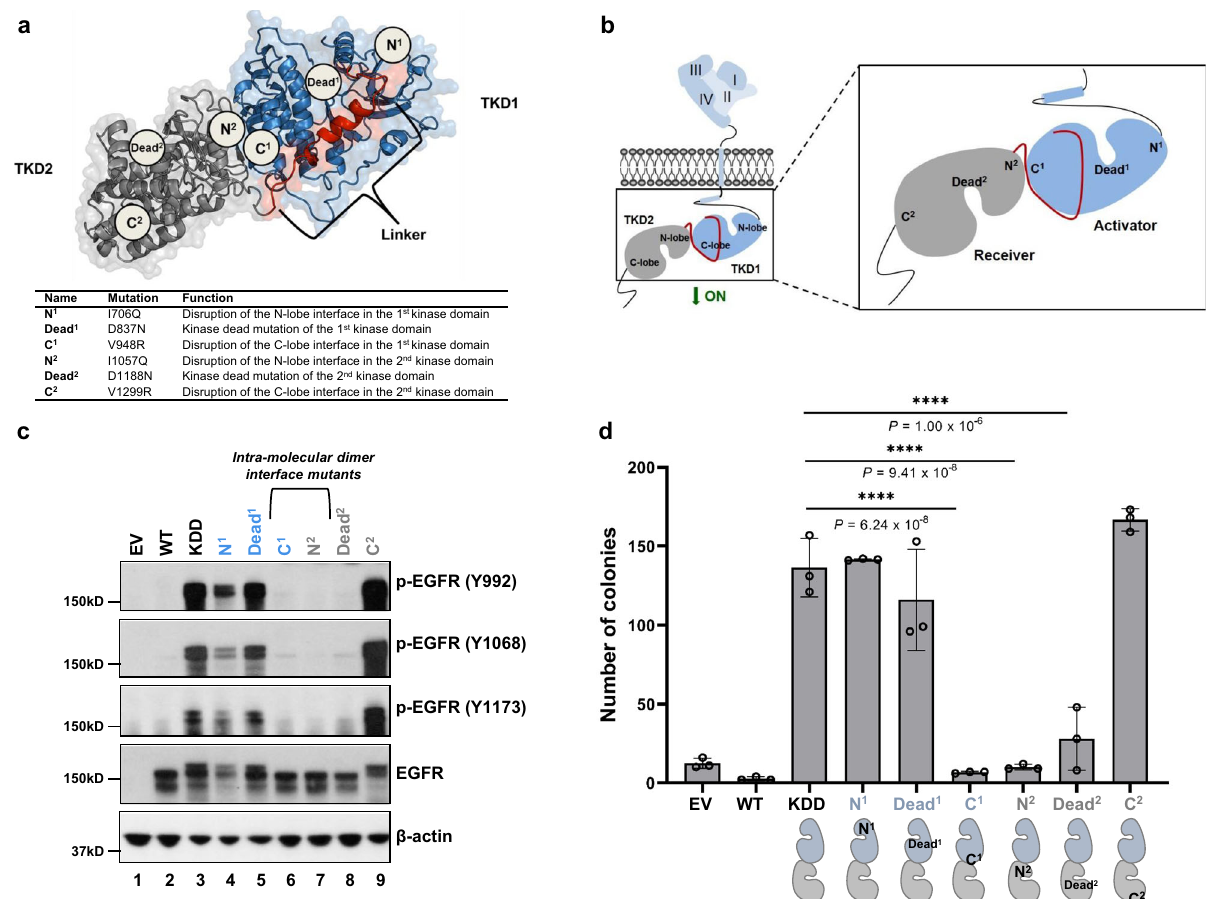
Fig. 1 Mutations disrupting the potential intra-molecular dimer interface abrogate phosphorylation of EGFR-KDD and anchorage-independent growth. a Ribbon diagram and space- fi lling model of EGFR-KDD kinase domains. Mutations constructed in this study were labeled. b Schematic representation of mutations we constructed in this study. We generated point mutations disrupting the potential intra- (C 1 , N 2 ) and inter-molecular (N 1 , C 2 ) dimer interface as well as mutations inactivating kinase activity of each kinase domain (Dead 1 , Dead 2 ). c YAMC cells stably expressing EGFR-KDD and its mutants. Cells were cultured for 48 h and then harvested and lysed for analysis. Total EGFR and auto-phosphorylation at three tyrosine sites were evaluated by western blot. n = 3 experiments were repeated independently with similar results. EV empty vector; WT, EGFR-WT; KDD, EGFR-KDD. d Soft agar assays were performed in six-well plates by using YAMC cells. 5000 cells were seeded in each well and colonies were counted after 4 weeks. n = 3 biologically independent replicates were examined over three independent experiments with similar results. Data are presented as mean values ± SD. One-Way ANOVA test with Bonferroni post hoc test was performed to obtain the adjusted P values. For a , the model coordinates are provided in Supplementary Data 2. For c and d , results are the representative of three independent experiments. Source data are provided as a Source Data fi